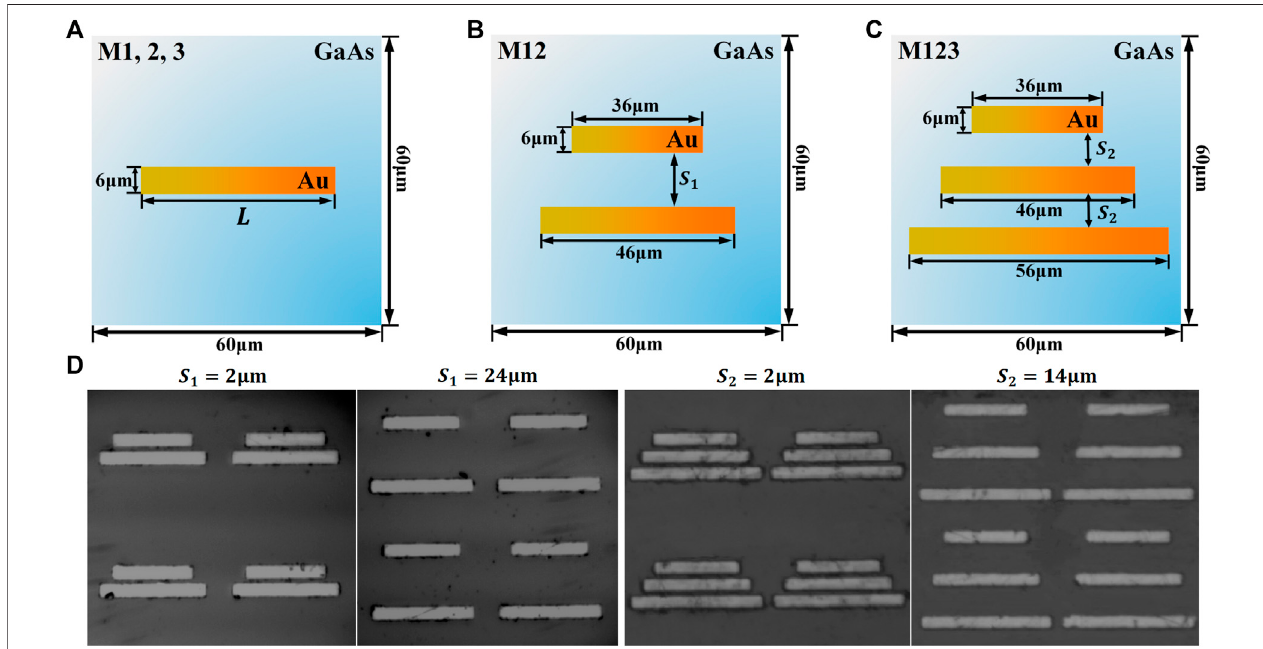
FIGURE1| Schematicdiagramsofthemetamaterialdesign: (A) singlebarwith L of36,46,and56 μ m,respectively; (B) M12consistingofM1andM2withspacing S 1 ; (C) M123 consisting of M1, M2, and M3 with spacing S 2 ; (D) some microscope photos of fabricated metamaterials for M12 with spacing S 1 and M123 with spacing S 2 ,